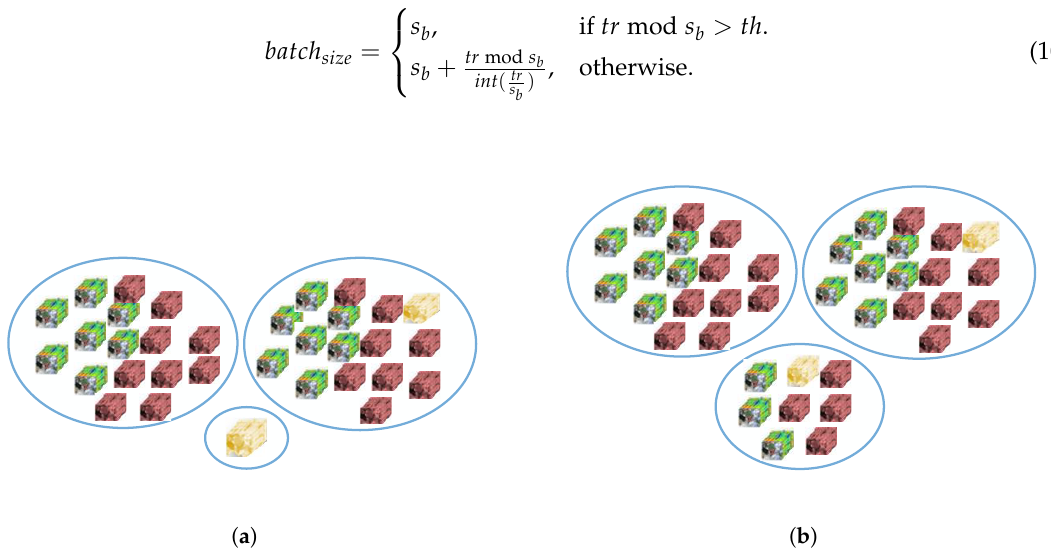
Figure 4. Example condition when the batch size cannot divide the training size evenly: ( a ) the latest mini-batch size is one, and ( b ) the latest mini-batch size is more than threshold (if the threshold is